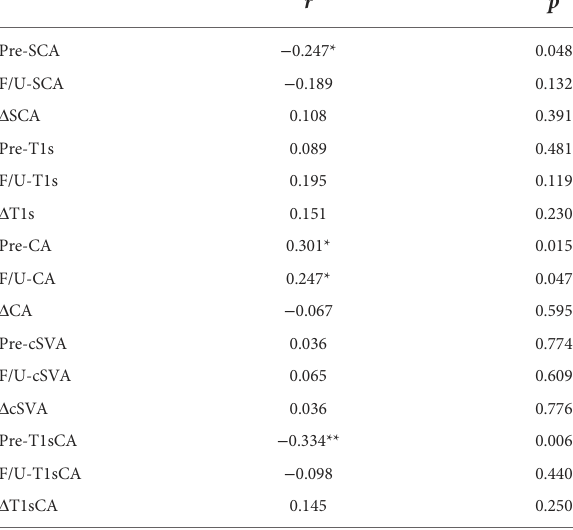
TABLE 5 Unvariate analysis between RR and radiological parameters.